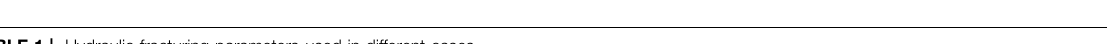
TABLE 1 | Hydraulic fracturing parameters used in different